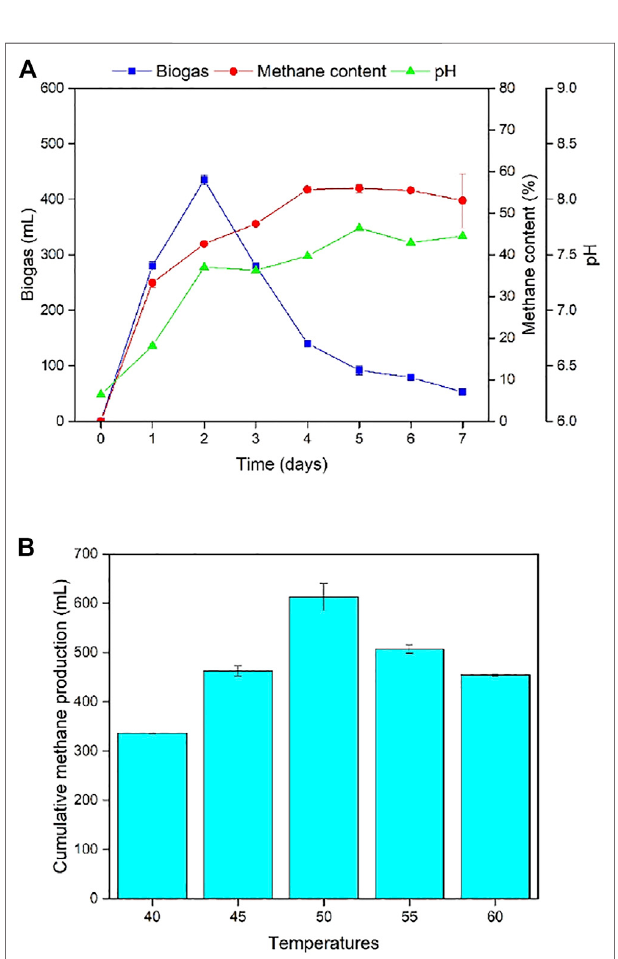
FIGURE 5 | (A) Daily biogas production, methane content, and pH for the second stage of TS-AD at 50 ° C. (B) Cumulative methane production for the second stage of TS-AD operated at different temperatures (TS-AD = Two stage anaerobic digestion).